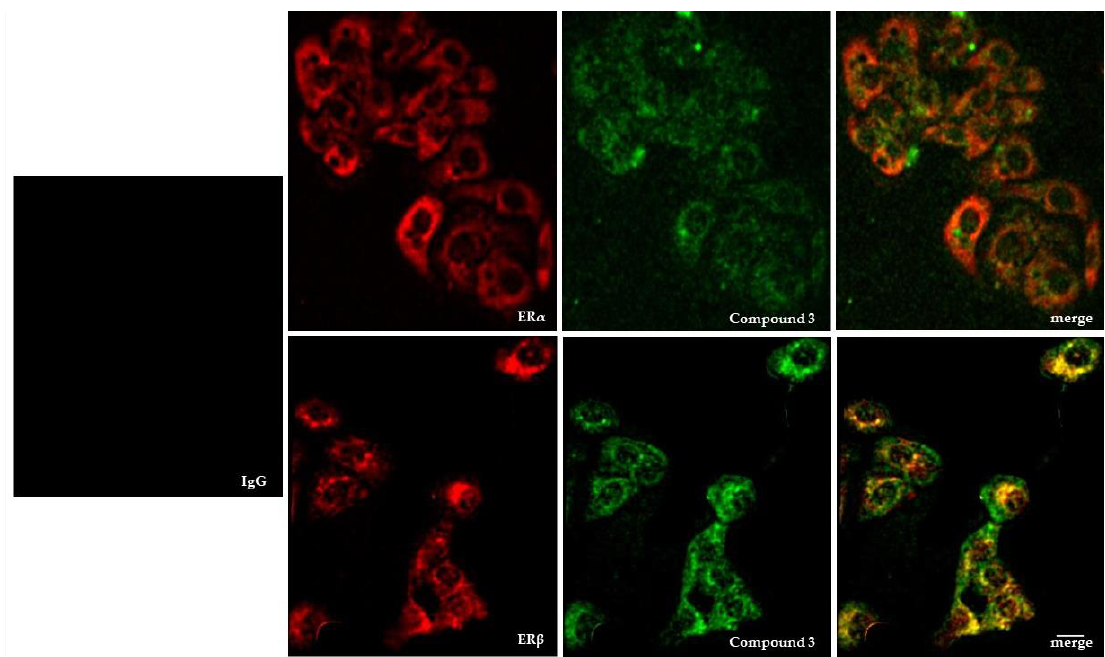
Figure 3. ERβ/ 3 complex in IGROV1 cells. IGROV1 cells were treated with 5 μM 3 for 6 h, and then Figure 3. ER β / 3 complex in IGROV1 cells. IGROV1 cells were treated with 5 µ M 3 for 6 h, and then fixed and immunostained for ERα or ERβ (red) and compound 3 (green). IgG, negative control. fixed and immunostained for ER α or ER β (red) and compound 3 (green). IgG, negative control. Yellow Yellow pixels represent ERβ/ 3 colocalization, indicating the formation of an ERβ/ 3 complex. Bar = 20 pixels represent ER β / 3 colocalization, indicating the formation of an ER β / 3 complex. Bar = 20 µ µm.